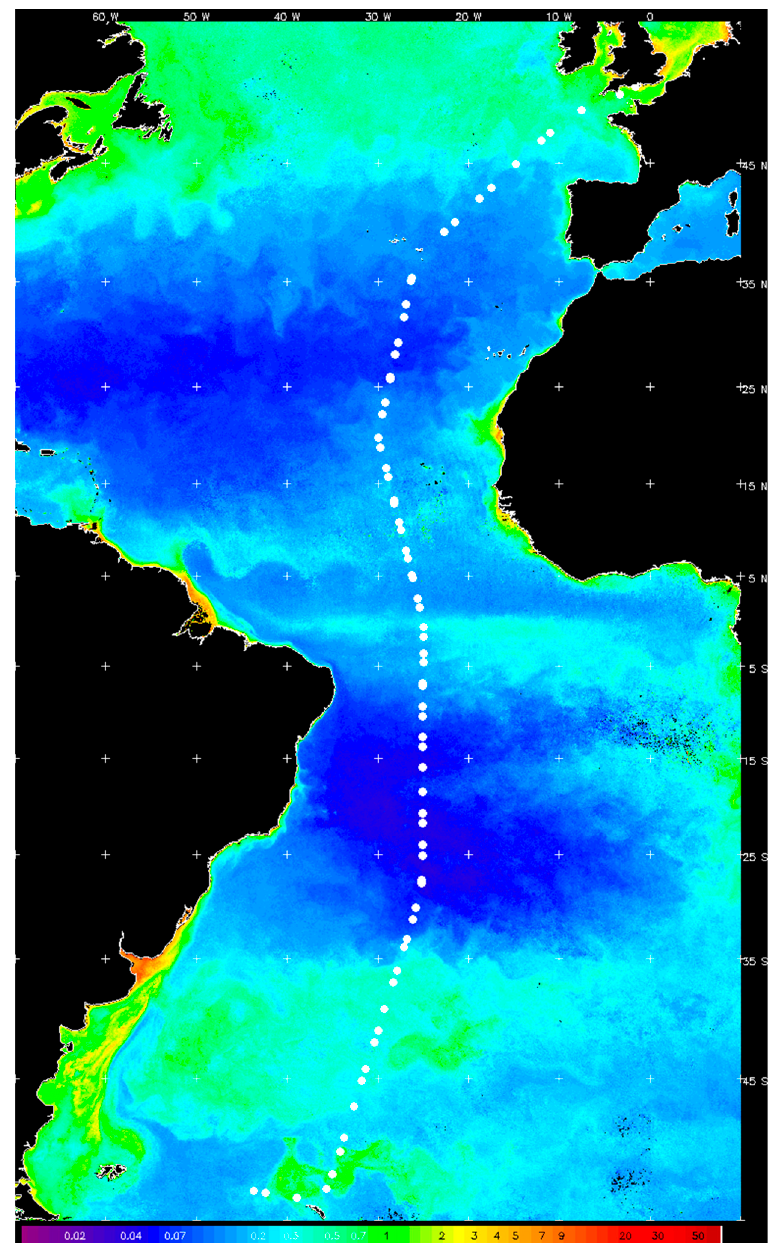
Figure 2. AMT27 campaign sampling stations superimposed on a NASA Visible Infrared Imager Radiometer Suite (VIIRS) Chl a composite satellite image from 19th September to 09th November 2017. The Chl a concentration scale is given below the image.